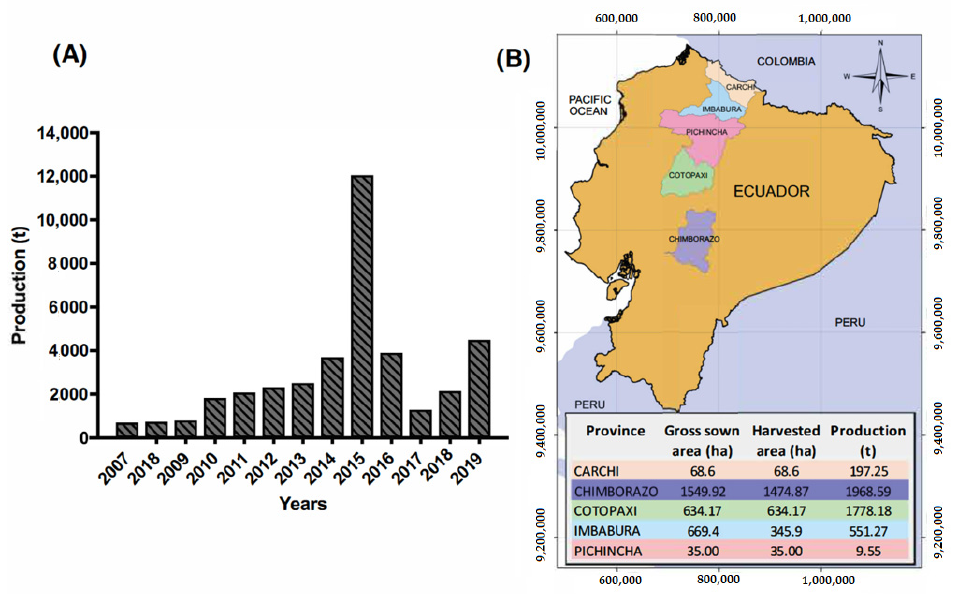
Figure 1. Quinoa production in Ecuador. ( A ) In the period from 2007 to 2019; ( B ) map including gross sown and harvested areas by province in 2019. Source: FAO and INEC-ESPAC [17,25]. In 2019, quinoa production increased again (4504 t) since many farmers’ associations, mainly in the provinces of Chimborazo and Cotopaxi, have stable international